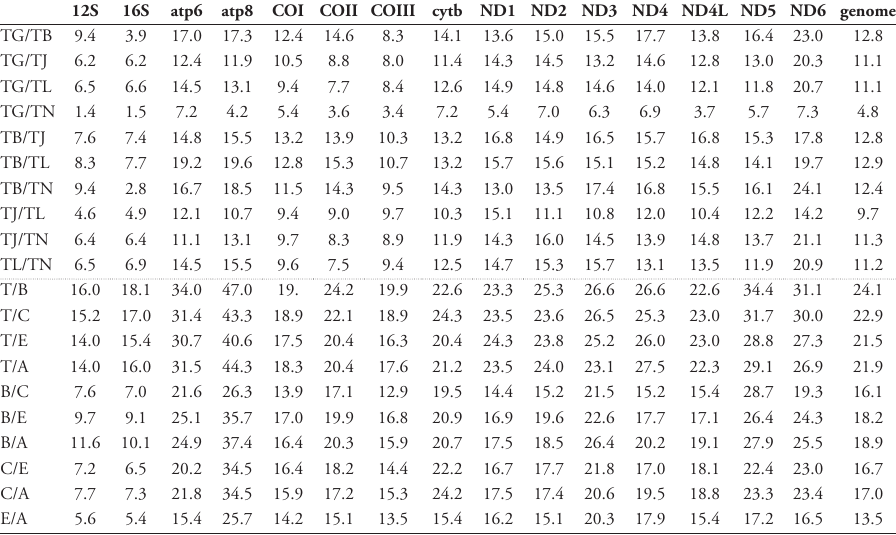
Table 6. The p-distance (*10 -2 ) between Trichiurus species (interspecific) and between genera within Trichiuridae (intergeneric) in each gene and mitogenome (excluding d-loop). T. japonicus (TJ), Trichiurus lepturus (TL), Trichiurus nanhaiensis (TN), T. gangeticus (TG), Trichiurus brevis (TB), Trichiurus (T), Benthodesmus (B), Aphanopus (C), Evoxymetopon (E), and Assurger (A). 12S 16S atp6 atp8 COI COII COIII cytb ND1 ND2 ND3 ND4 ND4L ND5 ND6